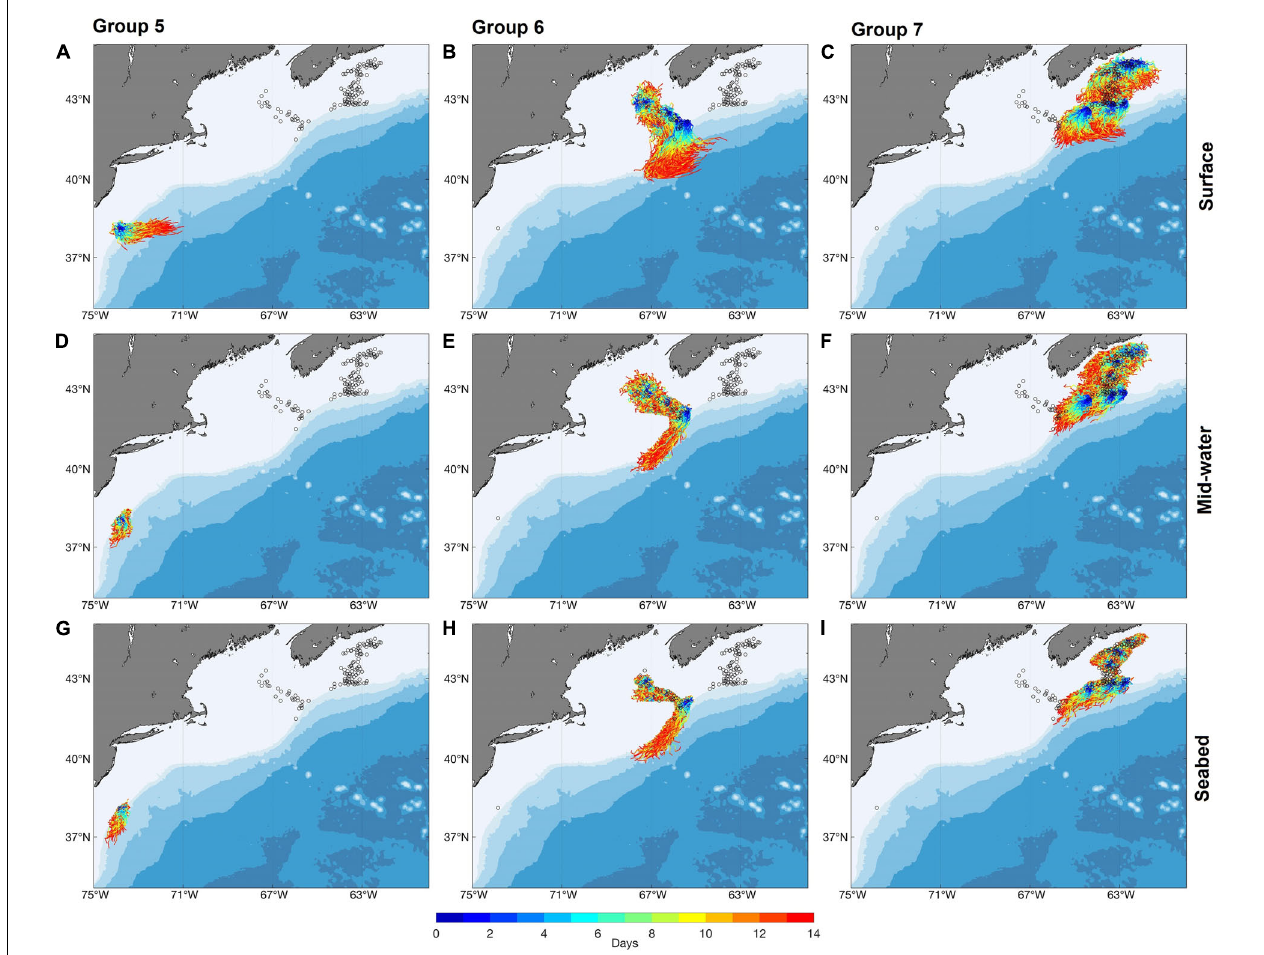
FIGURE 6 | Trajectories of particles released from occupied grid cells in Groups 5, 6, and 7 [Groups 5 (A,D,G) , 6 (B,E,H) , and 7 (C,F,I) ] at the surface (A–C) , mid-water (D–F) , and the seabed (G–I) in July using long-term averaged currents, modeled with k h = 250 m 2 s − 1 . (Open circles indicate the locations of occurrence records. For results from modeling with k h = 0, see Supplementary Figure 6 ).